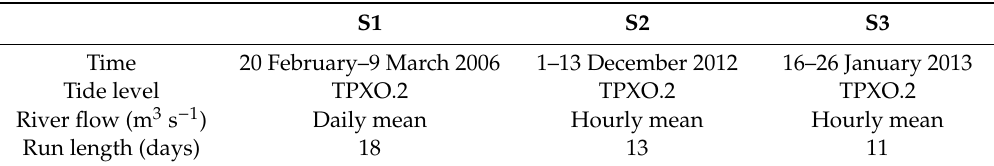
Table 2. Modelling